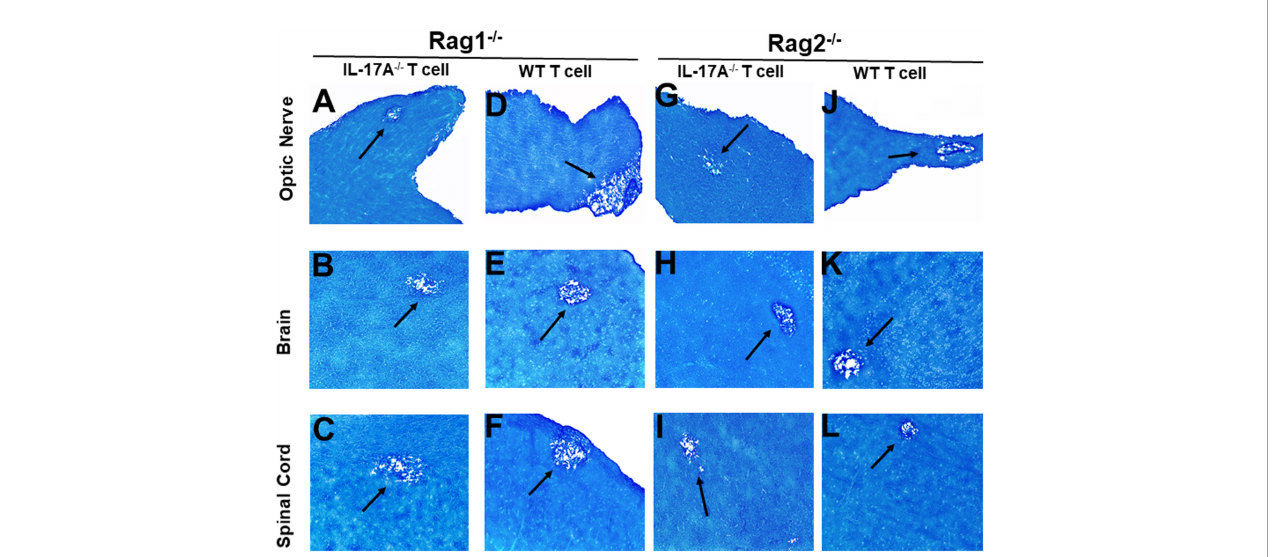
FIGURE 2 Adoptive transfer of IL-17A -/- and WT T cells to Rag mice. Naive T cells were isolated from fi ve IL-17A -/- and WT mice using a magnetic bead system. Isolated T cells were adoptively transferred via intraperitoneal injection (i.p.) into fi ve Rag1 -/- and Rag2 -/- mice. Two weeks post-adoptive transfer, mice were infected ocularly with 2 X10 5 pfu/eye of HSV-IL-2 virus. On day 14 PI, optic nerves (A, D, G, J) , brain (B, E, H, K) , and spinal cord (C, F, I, L) samples were harvested, sectioned, and stained with LFB. The left panel depicts a Rag1 -/- mouse transferred with IL17A -/- T cells (A, B, C) or wild type T cells (D, E, F) , respectively. The right panel depicts a Rag2 -/- mouse transferred with IL17A -/- T cells (G, H, I) or wild type T cells (J, K, L) , respectively. Representative sections are shown with arrows indicating areas of demyelination. x10 objective lens was used (100x